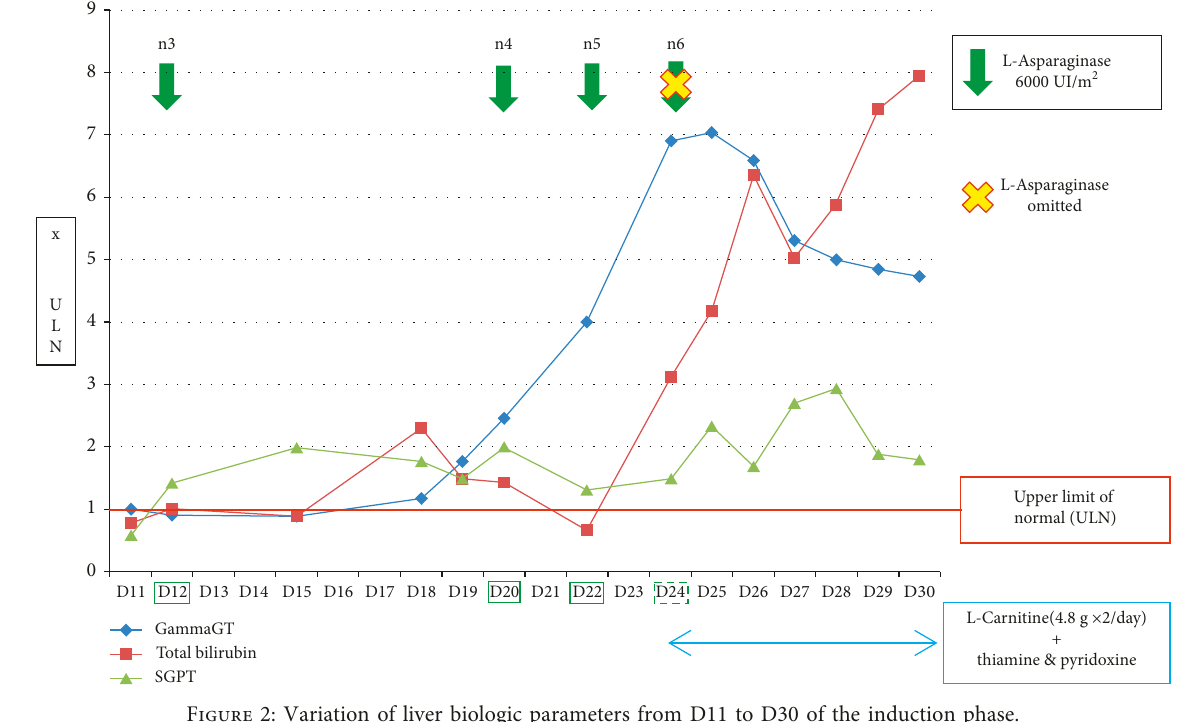
Figure 2: Variation of liver biologic parameters from D11 to D30 of the induction phase.